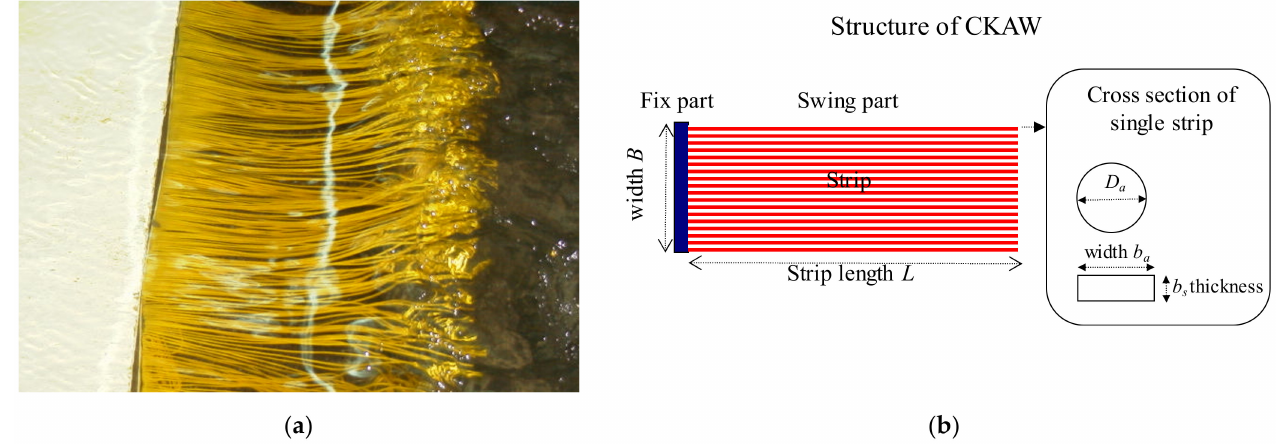
Figure 2. ( a ) Swinging of CKAW due to flow; ( b ) details of